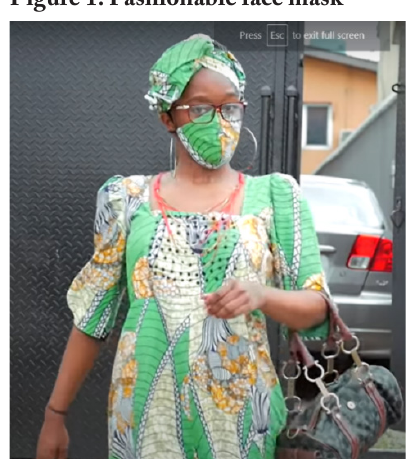
Figure 1: Fashionable face mask Figure 2: Mama Shem’s face